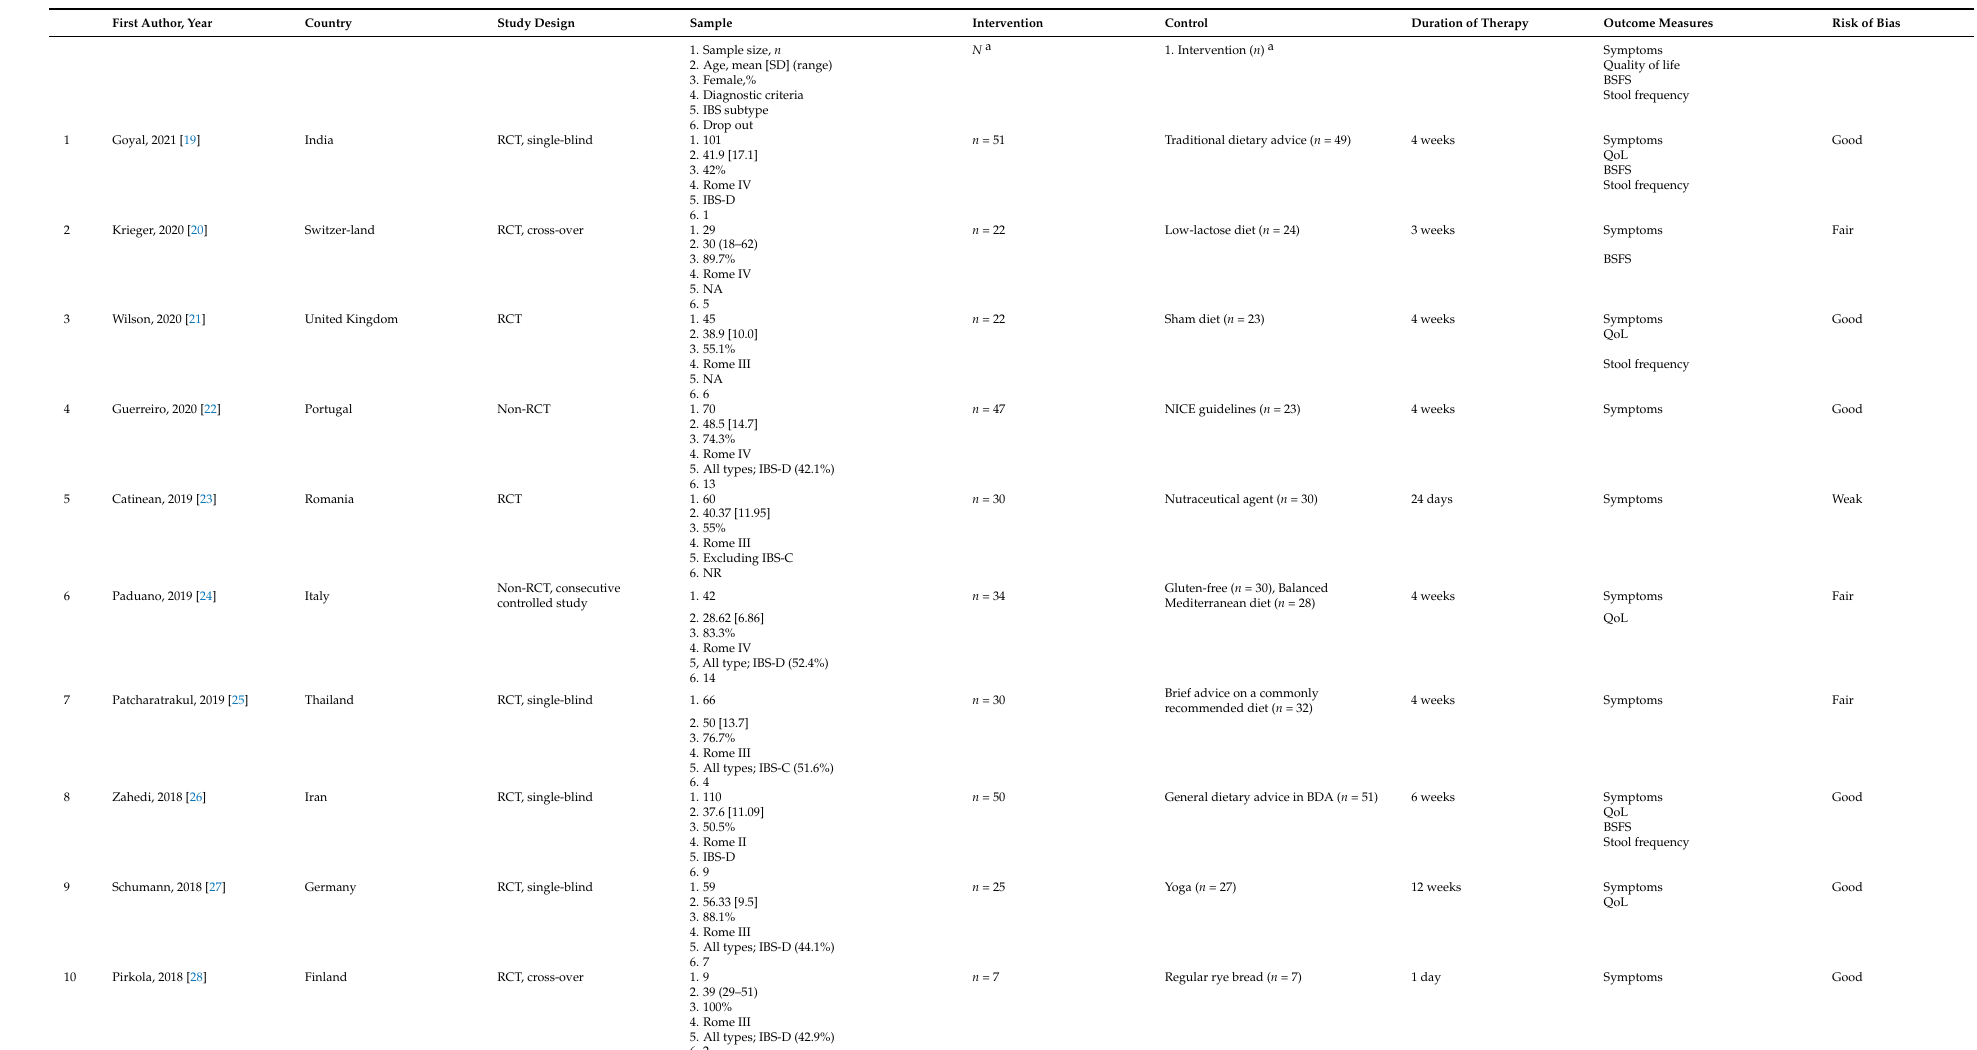
Table 1. Characteristics of studies included in the